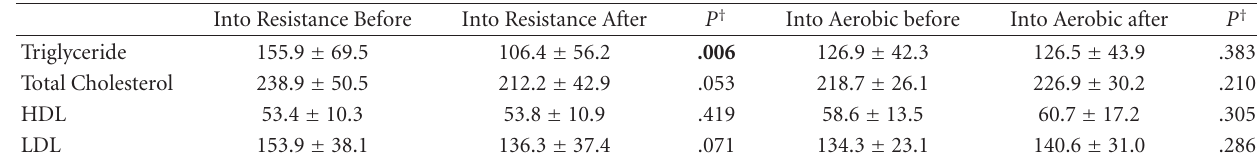
Table 2: Lipid profile in groups.